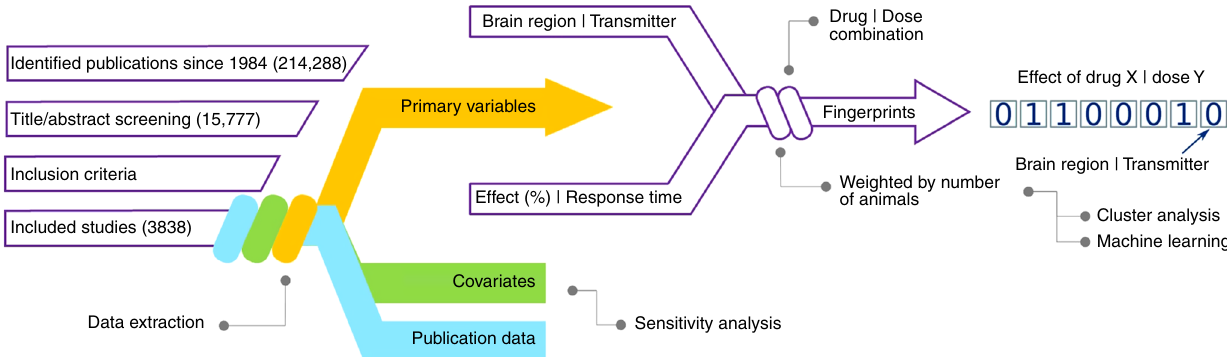
Fig. 1 Flowchart of data mining, extraction and fi ngerprint generation procedures. Keyword-based search of online databases and manual grey search of literature identi fi ed 214,288 publications since 1984, out of which 15,777 were screened for content. Three categories of data were extracted from 3838 studies that ful fi lled the inclusion criteria (microdialysis AND rat AND brain AND systemic drug administration). For each drug, dose pairing, the normalized effect was calculated as a meta-analysis weighted by the number of animals used in each study and the robustness of the values were estimated by sensitivity analysis with respect to covariates such as age, strain, sex and microdialysis parameters. The data was then transformed into bit arrays which represent the neurochemical response fi ngerprints within the neurochemical connectome of the